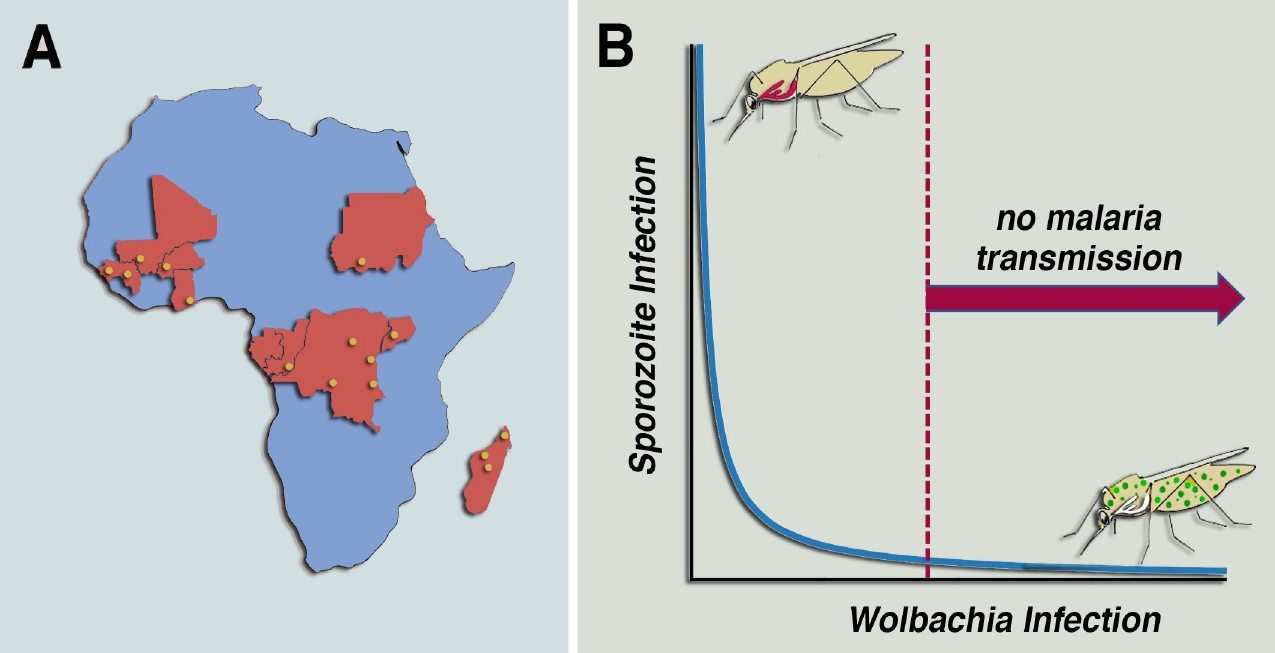
Fig 1. Effect of mosquito infection with native African Wolbachia strains on P . falciparum transmission. (A) Native Wolbachia infections were identified in independent field collections of A . gambiae sensu lato in several countries in sub-Saharan Africa. Approximate locations of field collections, when made available, are indicated as yellow circles. (B) The presence of systemic Wolbachia infection reduces P . falciparum sporozoite infection of mosquito salivary glands. The effect of native Wolbachia in Anopheles mosquitoes collected in Mali is dose dependent and follows a nonlinear negative correlation. These observations suggest that there is a threshold level of Wolbachia infection in mosquitoes above which malaria transmission would no longer be effective.